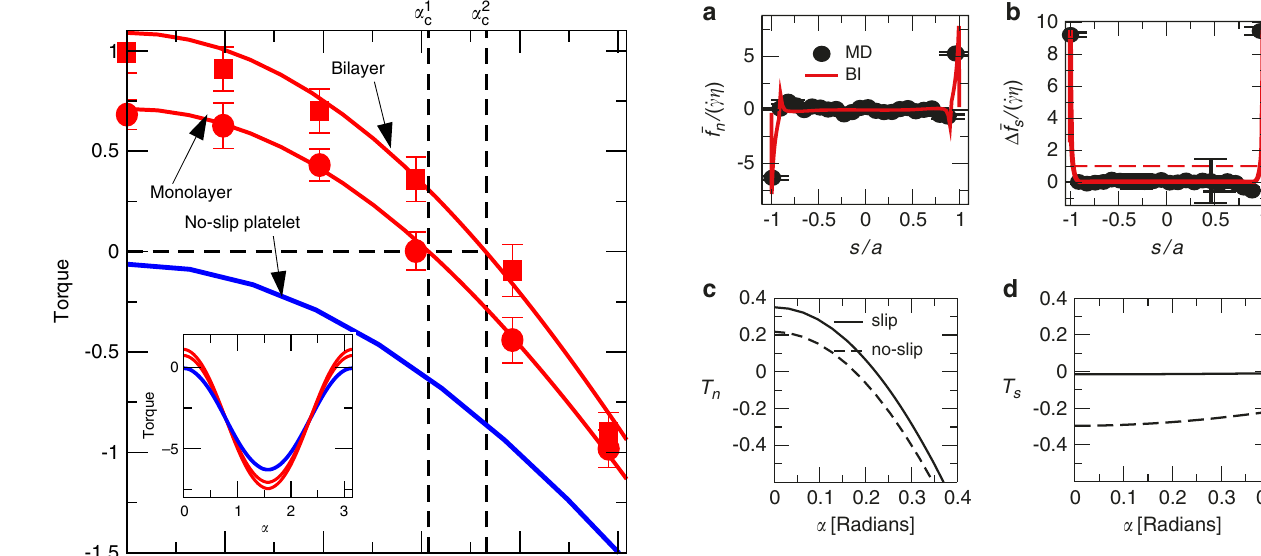
Fig. 4 Normal and tangential traction and their contribution to the torque. a , b Non-dimensional hydrodynamic traction normal ( a ) and tangent ( b ) to the surface of a graphene platelet for α = 0 and n = 2, comparing MD and BI simulations. Red dashed line is the no slip estimate Δ f = ð _ γη Þ ≊ 1. Error bars correspond to standard deviations in MD s measurements. c Torque component corresponding to normal traction R ð a 2 w _ γη Þ T ¼ s (cid:2) f S (left integrand term of Eq. (1)) as a function of the n n d S orientation angle α for a no-slip (dashed line) and slip (full line)